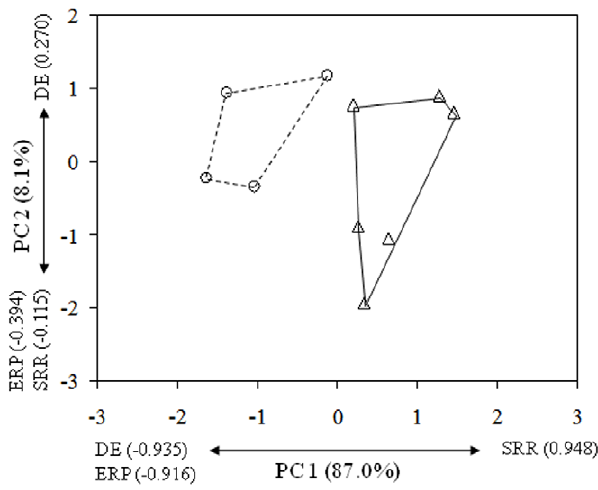
Figure 5. Male calling songs of Sagacampbellicampbelli ( D ) and S.c.gracilis ( # ) are clearly different. Plots of scores along the first and second principal components (PC) are shown. Variance proportions represented by each PC are indicated together with the factor loadings (correlation). Additional abbreviations: DE – duration of echemes; ERP – echeme repetition period; SRR – syllable repetition rate.